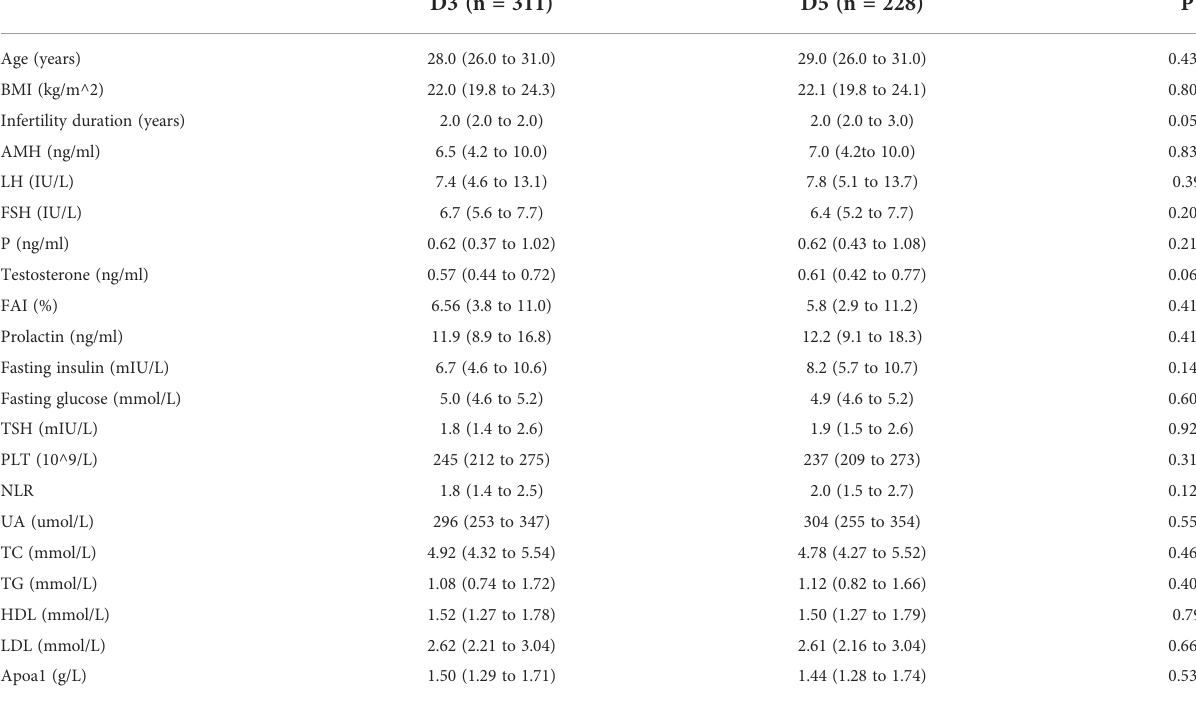
TABLE 1 Baseline Characteristics of Participants.